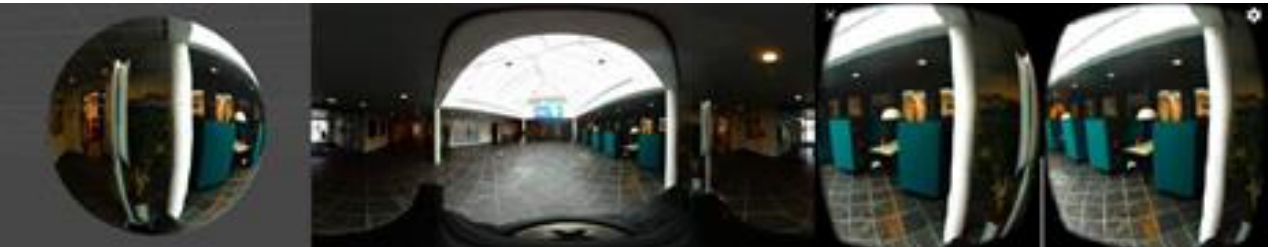
Figure 4. On the left: sphere providing omnidirectional view. In the middle: equirectangular projection. On the right: stereoscopic view.